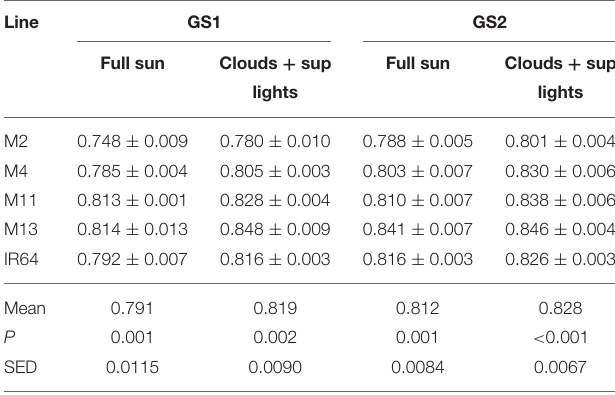
TABLE 4 | Maximum quantum yield of PSII (Fv/Fm) measured after 20 min dark adaptation. Line GS1 GS2 Full sun Clouds + sup Full sun Clouds + sup